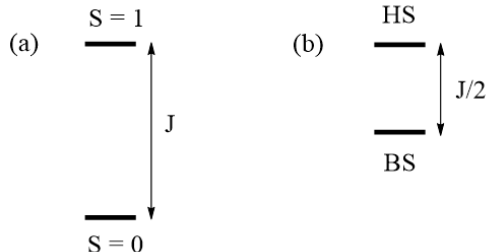
Figure 4. Relationships of the spin exchange J to the energy difference between two spin states of a spin dimer made up of two S = 1/2 ions in terms of ( a ) the eigenstates and ( b ) the broken-symmetry states. The legends HS and BS in ( b ) refer to the high-symmetry and broken-symmetry states, respectively.